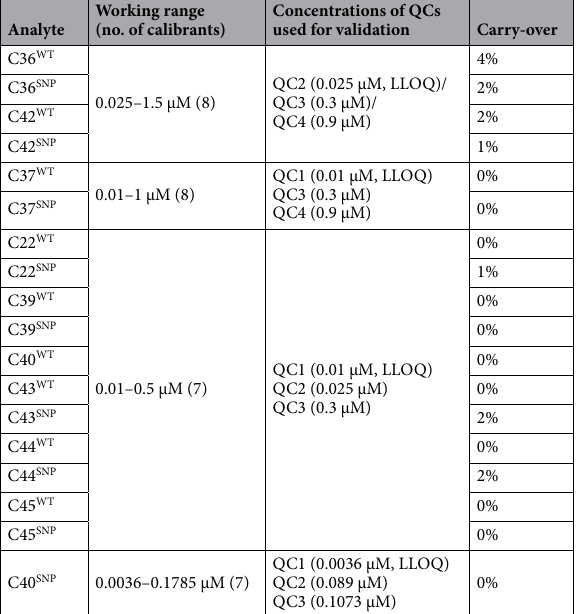
Table 1. Working ranges, QC sample concentrations and results of carry-over experiments. Carry-over is determined as the ratio of peak areas measured in blank albumin sample to peak areas of respective LLOQs (%).